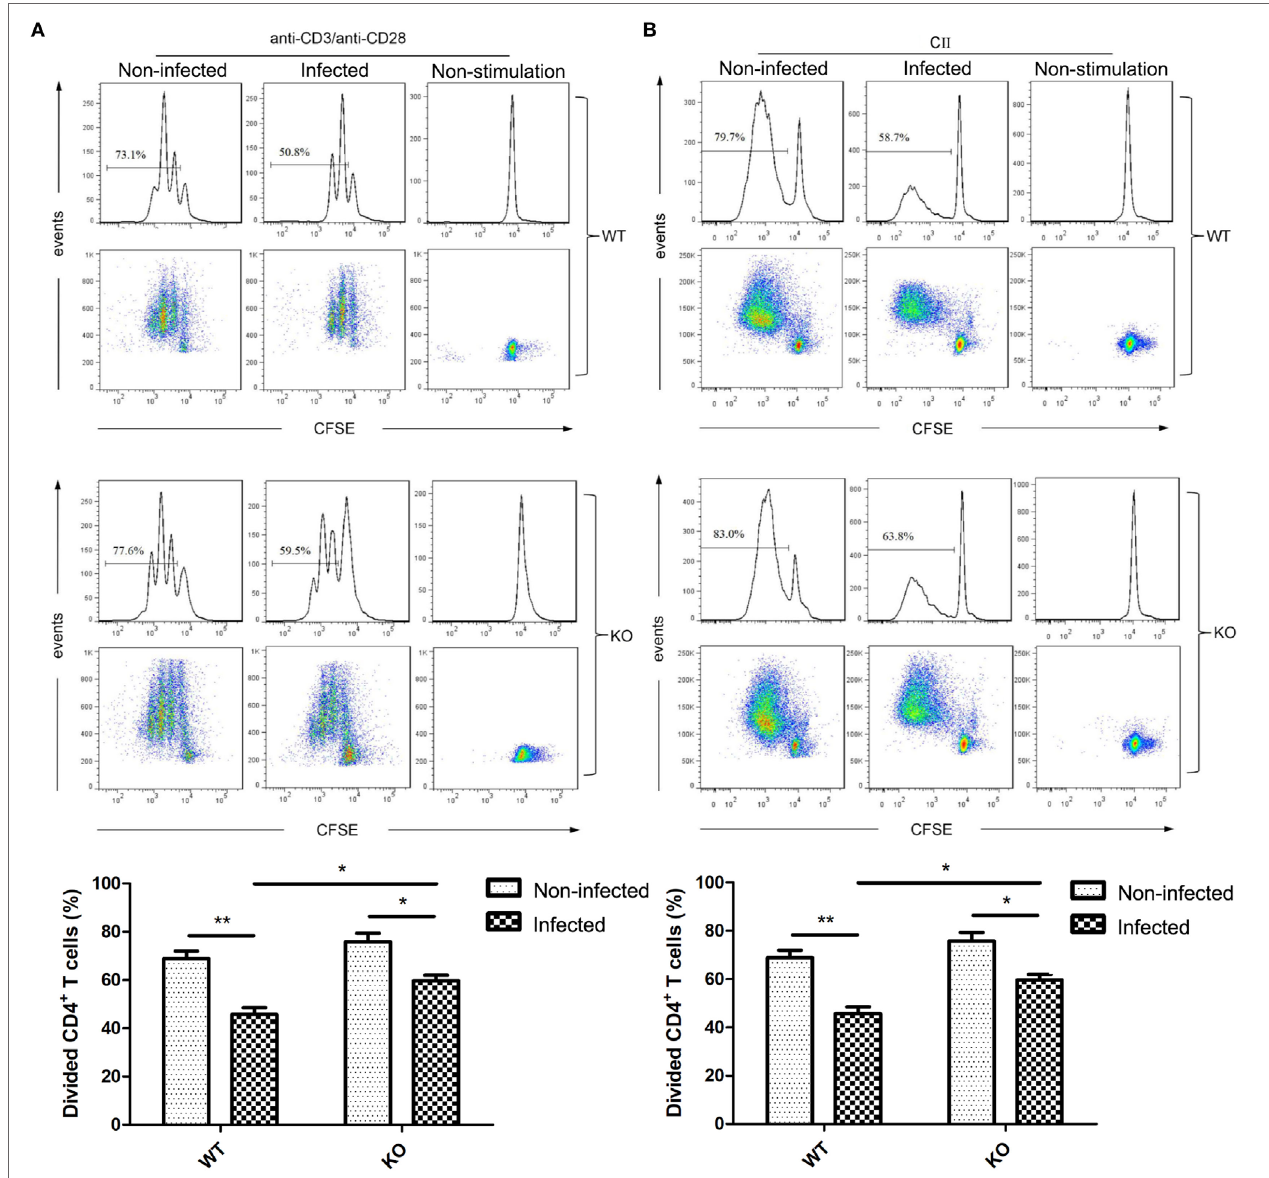
FigUre 5 | Programmed death 1 (PD-1) knockout partially restored suppressed proliferation of CD4 + T cells in Trichinella spiralis -infected mice. CD4 + T cells were isolated from C57BL/6 wild-type (WT) and PD-1 − / − mice and stained with CFSE. Decay of CFSE staining of CD4 + T cells was determined by flow cytometry. (a) FACS analysis of CD4 + T cell proliferation in response to non-specific stimulation. Purified CD4 + T cells from spleen of uninfected or T. spiralis -infected mice at day ≥ 35 of infection were stained with CFSE and incubated in the presence of anti-CD3/anti-CD28 for 72 h. (B) FACS analysis of CD4 + T cells proliferation in response to type II collagen (CII)-specific stimulation. Mice with or without T. spiralis infection (at day ≥ 35 of infection) were immunized with CII. CD4 + T cells were purified from LNCs of mice at day 10 post CII immunization and stained with CFSE, then incubated in the presence of CII (10 µg/ml) for 72 h. Irradiated naïve splenocytes were used as antigen- presenting cells (APCs). Data were expressed as mean ± SEM from two independent experiments ( n ≥ 3 mice per group). ** P < 0.05; * P < 0.01 (paired Student’s t